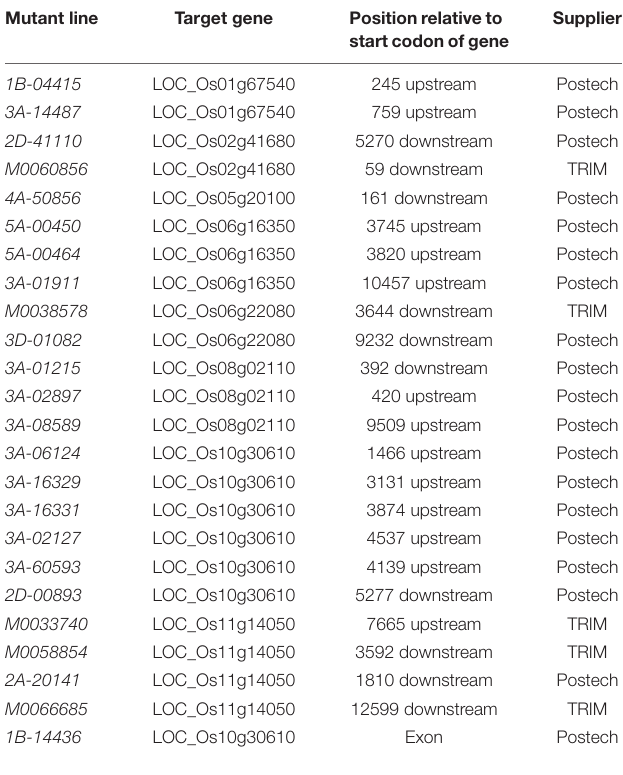
TABLE 1 | Mutant lines, target genes, position of the insert relative to the gene and supplier of the seeds. Mutant